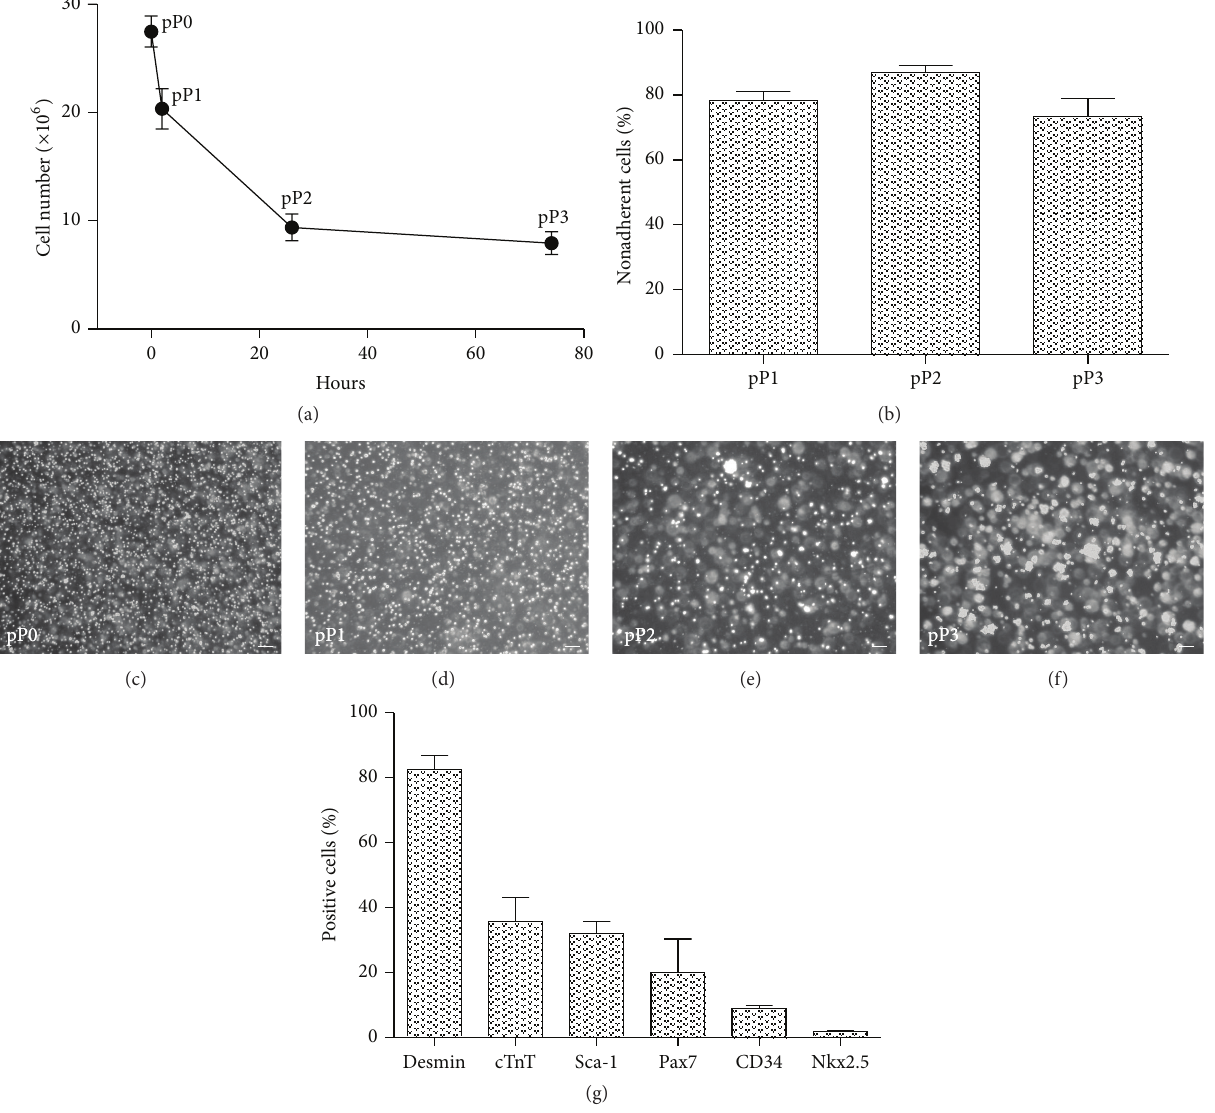
Figure 1: Isolation of MDSCs from neonatal murine skeletal muscles. (a) Total number of nonadherent cells (per g of muscle tissue) and ratios of nonadherent cells (b) during three preplating steps (pP1–pP3). Panels (c–f) show representative images of nonadherent cells